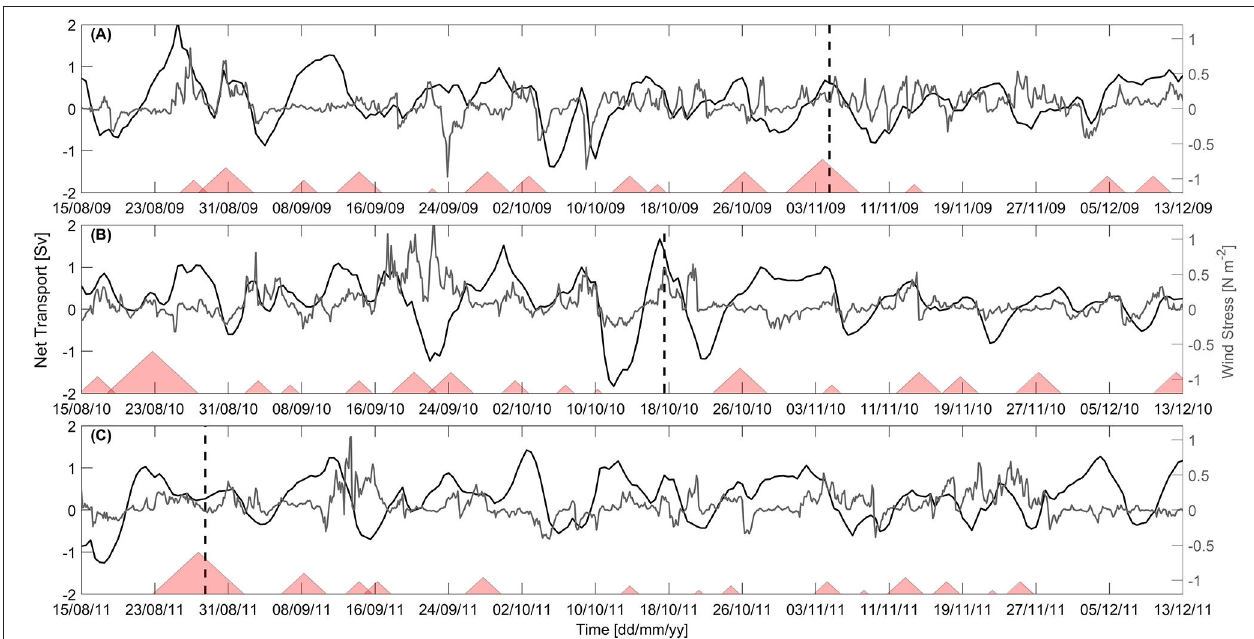
FIGURE 6 | Detided modeled transport of the d’Urville Current in Sverdrups (Sv, black line), surface U-momentum wind stress (gray line) and occurrence of LSMFs (red triangles) in Greater Cook Strait for (A) spring 2009, (B) spring 2010, and (C) spring 2011. Transport and wind stress were averaged over the width of the d’Urville Current along transect indicated on Figure 8A . Date of the two case study LSMFs and absence of LSMF analyzed in this study overlayed as black dashed lines for (A) LSMF on November 4, 2009, (B) Absence of LSMF on October 17, 2010, and (C) LSMF on August 28, 2011. The presence of LSMFs is indicated by triangles, with LSMF duration proportional to the corresponding triangle